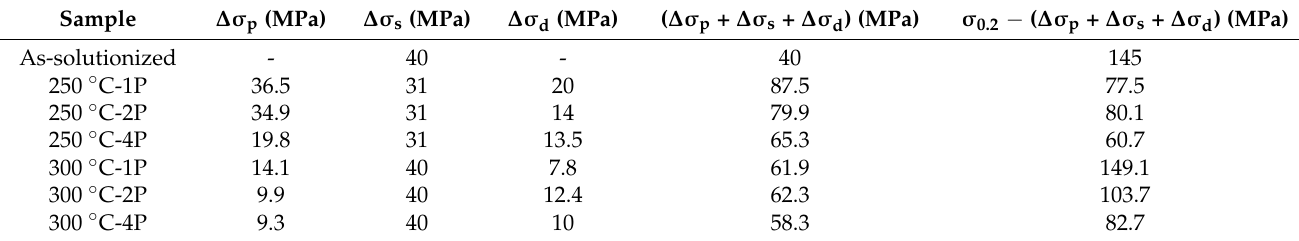
Table 3. Contribution of different strengthening mechanisms to the yield strength of samples deformed at 250 ◦ C and 300 ◦ C.